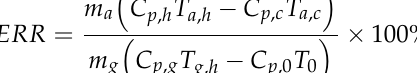
Figure 7. The temperature profile of gases and fillings along with height in a stable cycle.